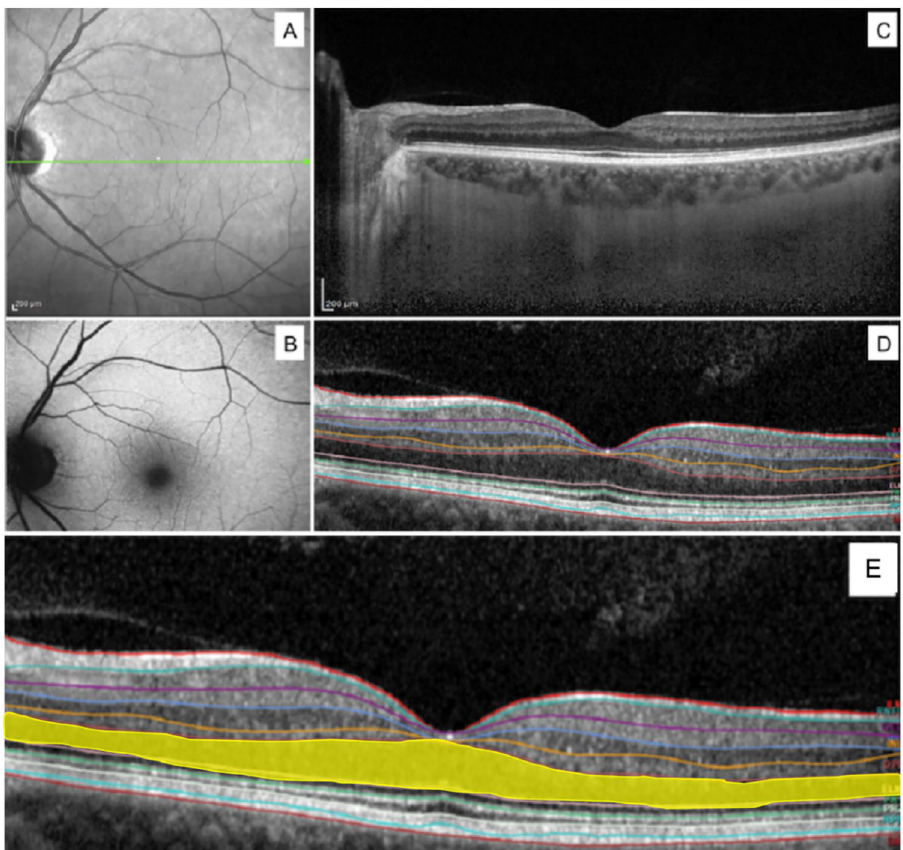
Figure 3. Representative example of the left eye of a patient with MELAS. Infrared ( A ), Autofluorescence ( B ), SD-OCT B-scan centered at the fovea with EDI mode ( C ); automated segmentation details of Spectralis ( D ). ONL highlighted in yellow for better visualization; IR and AF did not show changes; full macular volume and ONL volume decreased in SD-OCT analysis for eye’s MELAS patient ( E ). Inner limiting membrane (ILM), retinal nervous fiber layer (RNFL), ganglion cell layer (GCL), inner plexiform layer (IPL), inner nuclear layer (INL), outer plexiform layer (OPL), external limiting membrane (ELM), photoreceptor inner layer (PR1), photoreceptor outer layer (PR2), retinal pigment epithelium (RPE), Bruchs membrane